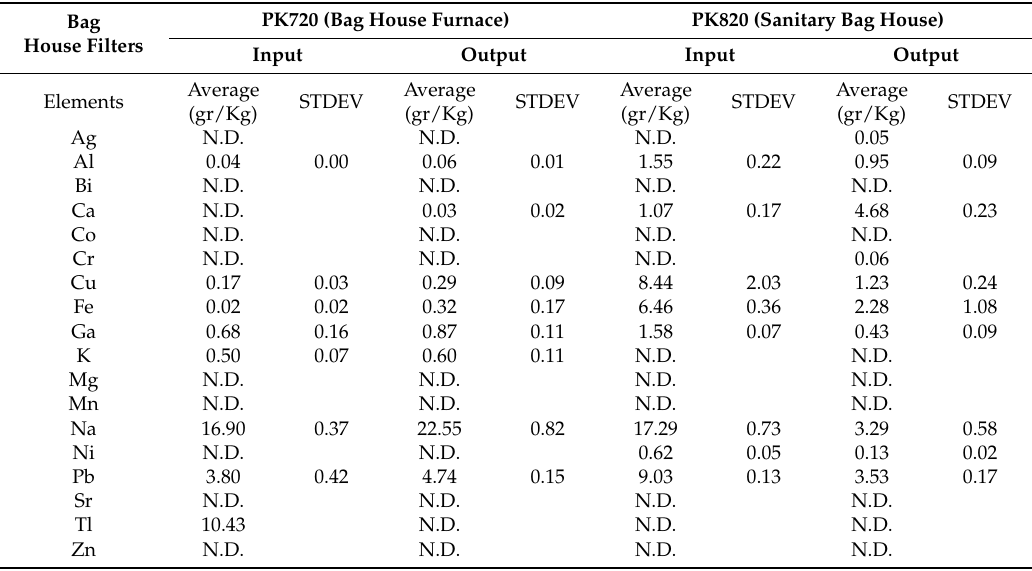
filters analysis, and LOQ from heavy metal concentrations in the dust from Gravity Settlers and from Bag houses are indiacted, respectively. Table 1. Heavy metal concentrations in bag houses PK720 (bag house furnace) and PK820 (sanitary